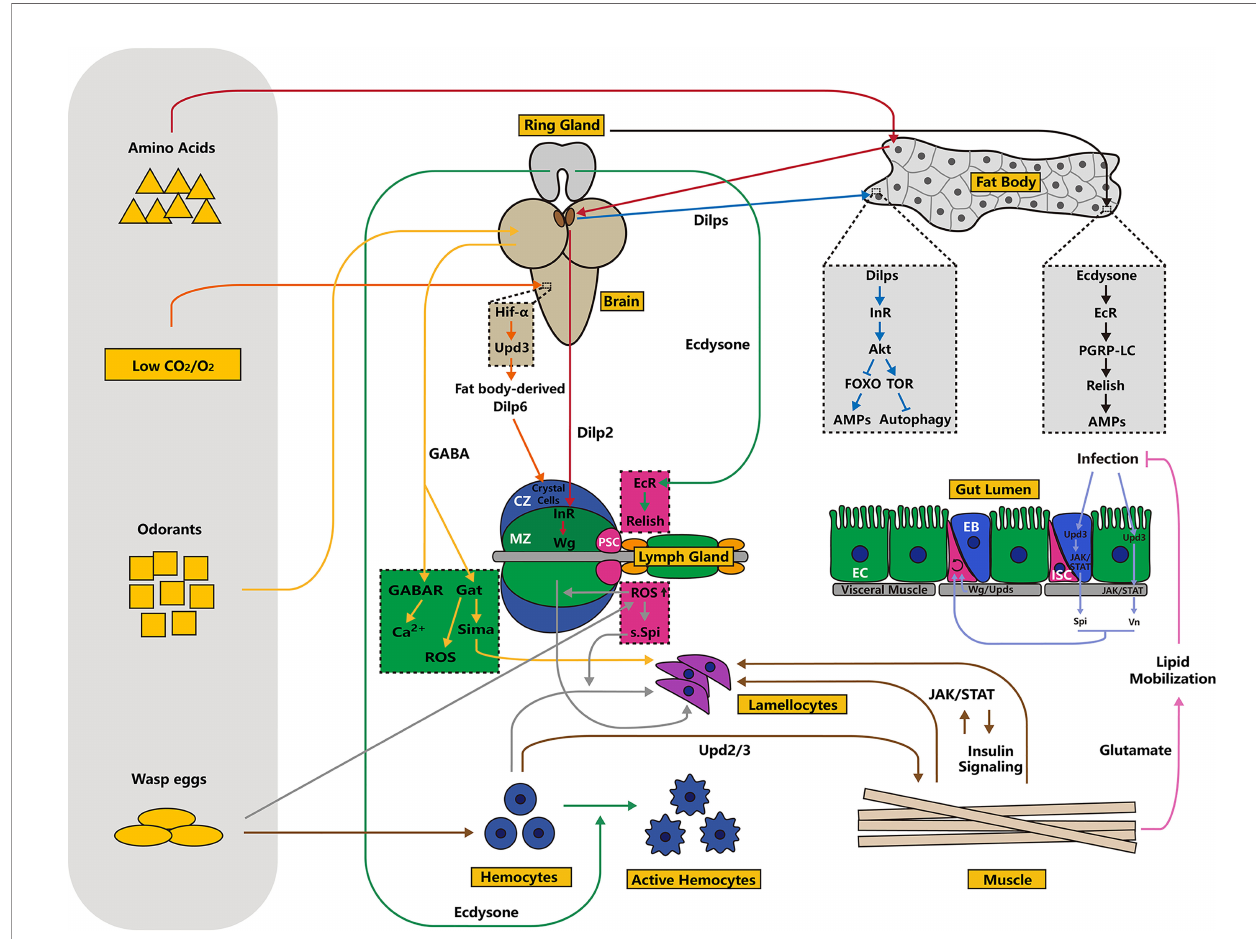
FIGURE 3 | Schematic overview of tissue communication in innate immunity. In addition to autonomous regulation inside immune organs, homeostasis of the immune system is regulated by external signals emitted by other tissues, including the brain, ring glands, muscles and others. Tissue communication is largely dependent on two types of hormones: ecdysone and insulin. Moreover, ligands, including Upds, Vn and Spi, act as “ messengers ” in this process. Typically, the lymph gland is sensitive to nutrient status, oxygen concentration, odor signals and other environmental factors. Different processes or signaling pathways are indicated by arrows of different